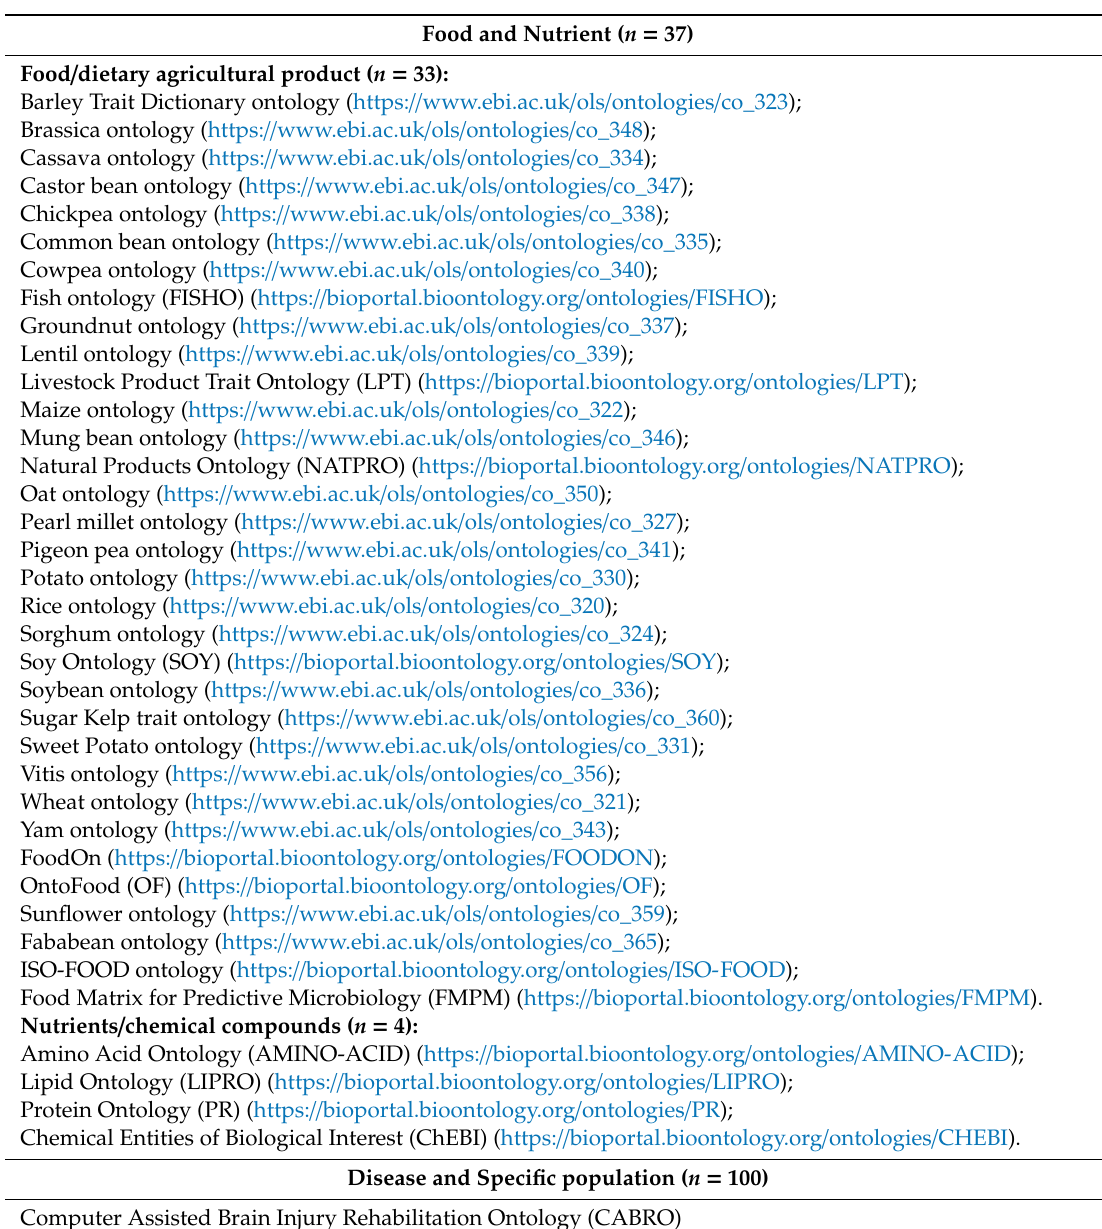
Table A2. Classification of selected ontologies according to the scope of ONE (complete list). Food and Nutrient ( n =